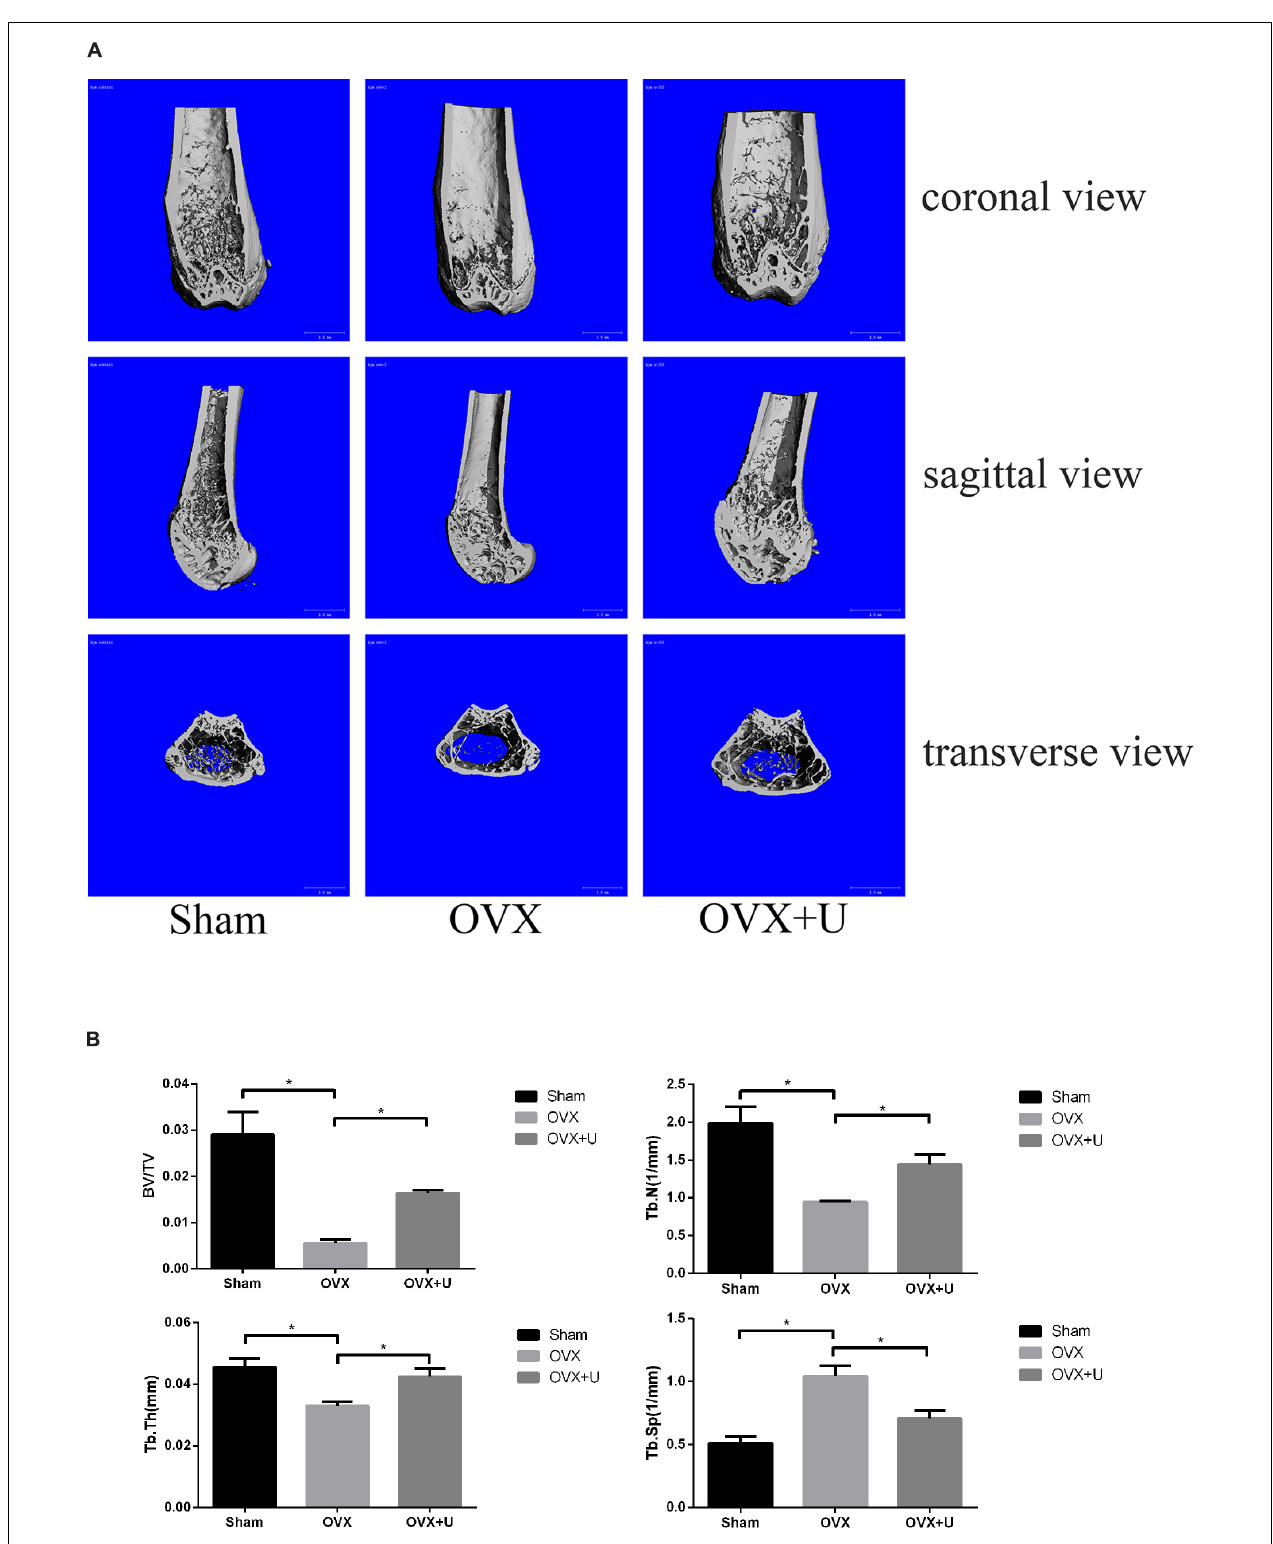
FIGURE 1 | Ulinastatin inhibits bone loss induced by OVX. (A) µ -CT images of the trabecular bone of distal femoral metaphysis from the SHAM, OVX, and OVX + ulinastatin groups. (B) The trabecular structural parameters of the distal femur: trabecular bone volume/tissue volume (BV/TV), trabecular number (Tb.N), trabecular thickness (Tb.Th), and trabecular separation (Tb.Sp). Data are presented as means ± SD . n = 10 and ∗ P < 0.05.